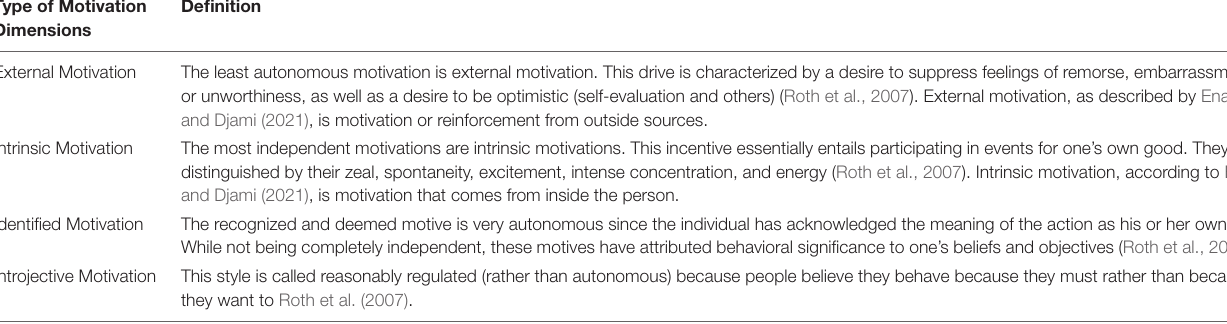
TABLE 1 | The definition of Roth et al.’s (2007) Motivation